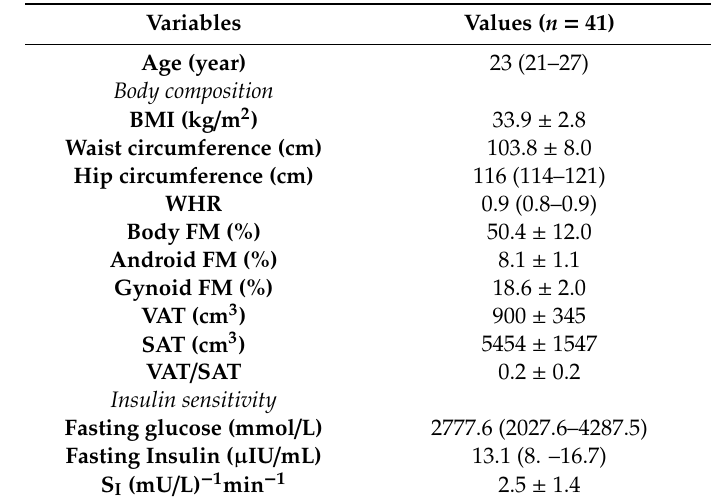
Table 1. Characteristics of participants.